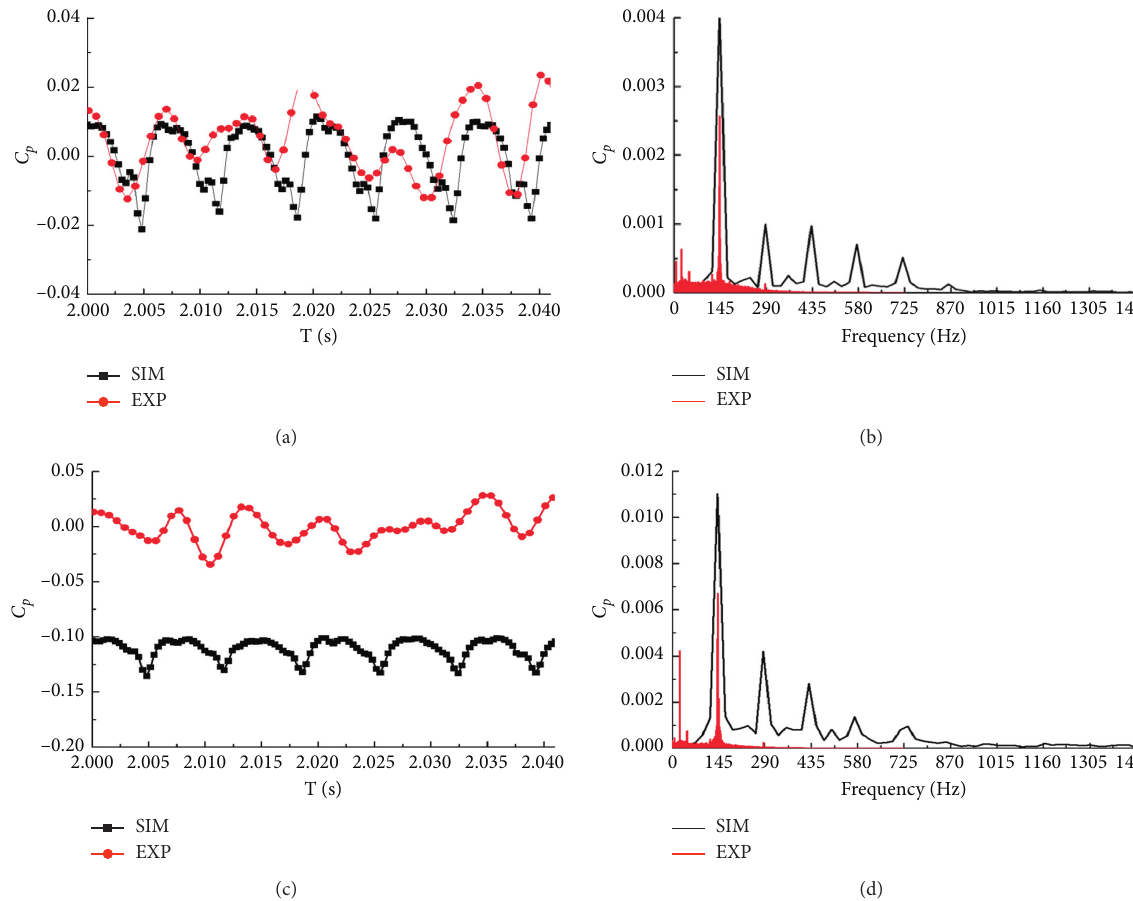
Figure 4: Comparison between the numerical simulation and the experiment of the pressure pulsation at 1.0 Q frequency domain. (c) P 4 time domain. (d) P 4 frequency